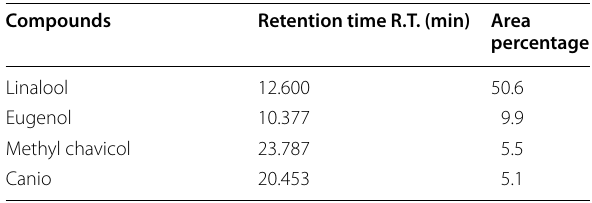
Table 12 Chemical composition of Ocimum basilicum essential oil Compounds Retention time R.T. (min) Area